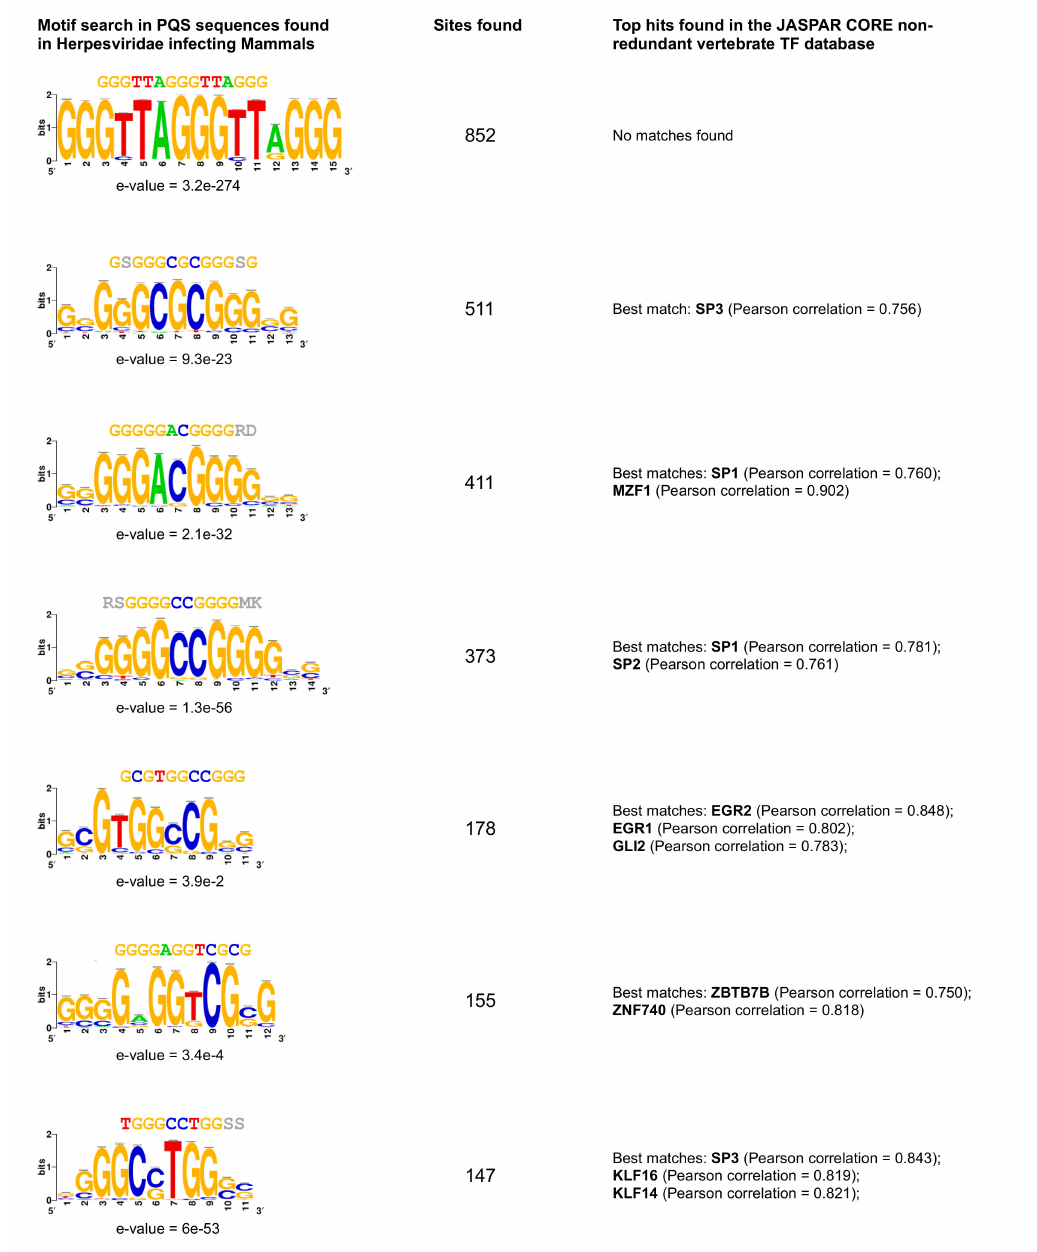
Figure 5. Consensus motif discovery in the quadruplex sequences found in mammalian herpesviruses. Top motifs found within the 5767 PQSs present in the 65 assemblies of herpesviruses infecting mammalian hosts. E-values are specified next to each sequence logo (the relative sizes of the letters indicate their frequency in the sequences and the total height of the letters depicts the information content of the position, in bits). The “Sites found” column indicates the number of times each particular motif was found in all the